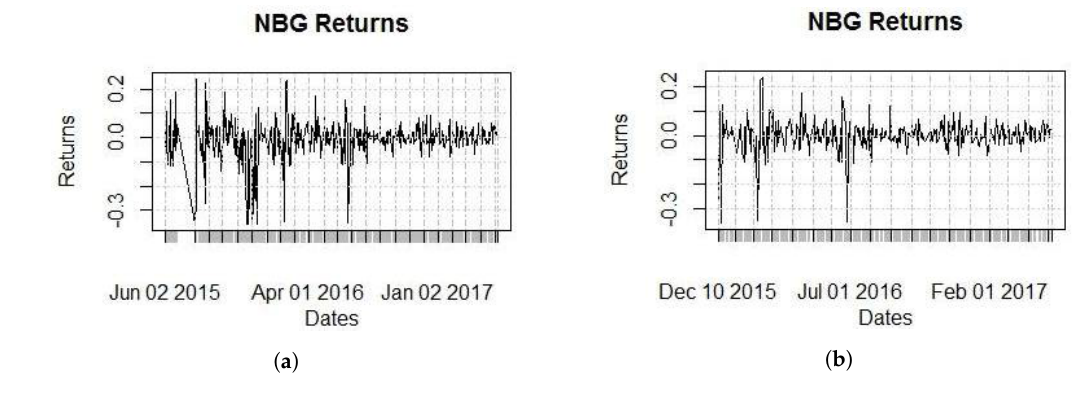
Figure 5. NBG Returns 2015–2017. ( a ) 2015–2017 (I); ( b ) 2016–2017